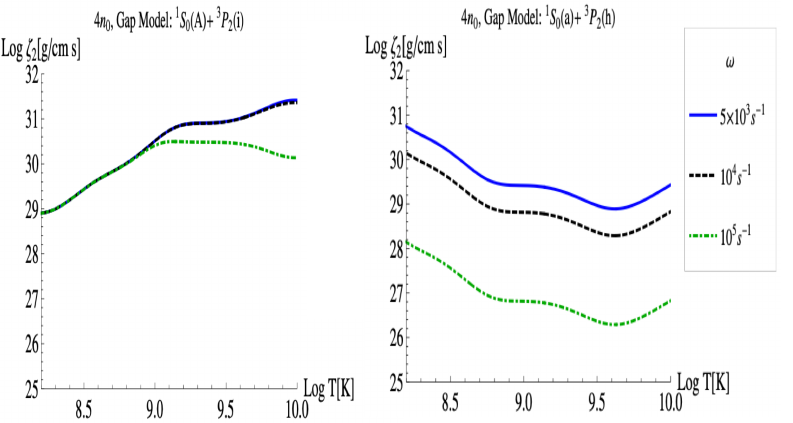
Figure 7. ζ 2 frequency-dependent bulk viscosity coefficient as a function of the temperature for 4 n 0 and frequencies between 10 3 and 10 5 s − 1 for the two neutron gap models. Figure adapted from [8,18]. Adapted from [18] with the permission of AIP